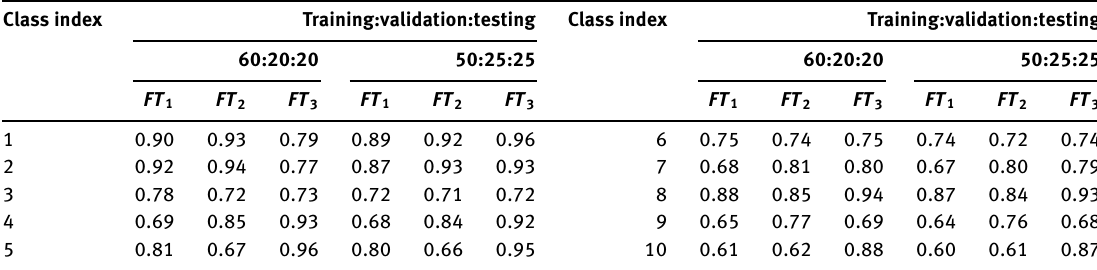
Table 1: Class-wise Performance of All Feature